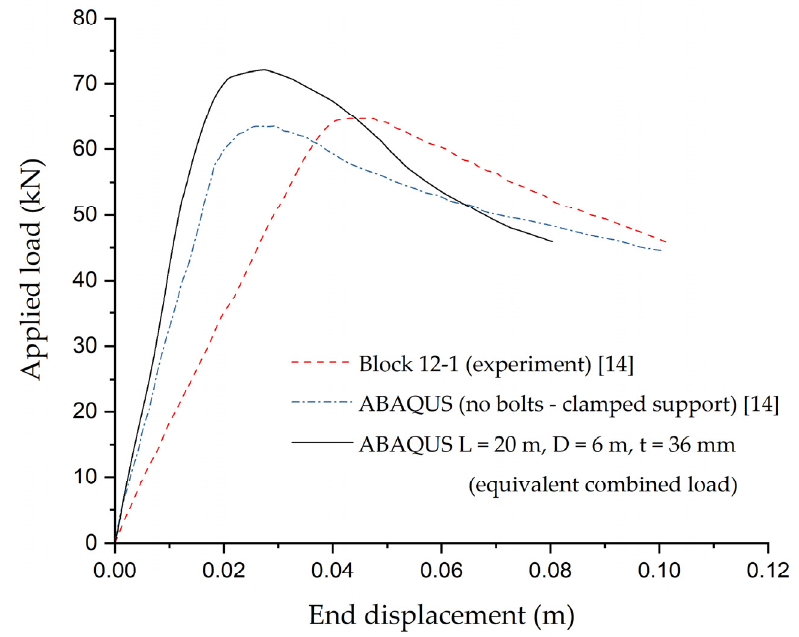
Figure 11. Load-displacement curves of experimental and numerical results [14], the black solid line represents the model under the equivalent combined load in this study.